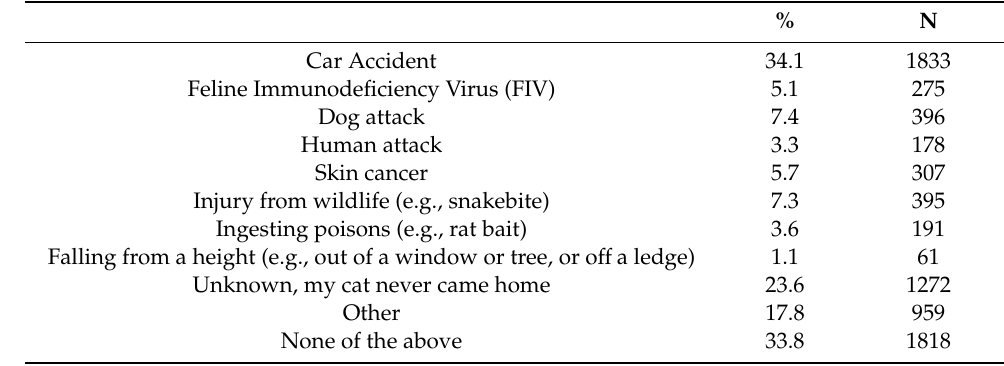
Table 1. The percentage of cat owners in this sample who reported having lost a cat in the past to each of the situations listed below related to an outdoor lifestyle. Participants were able to select multiple responses.